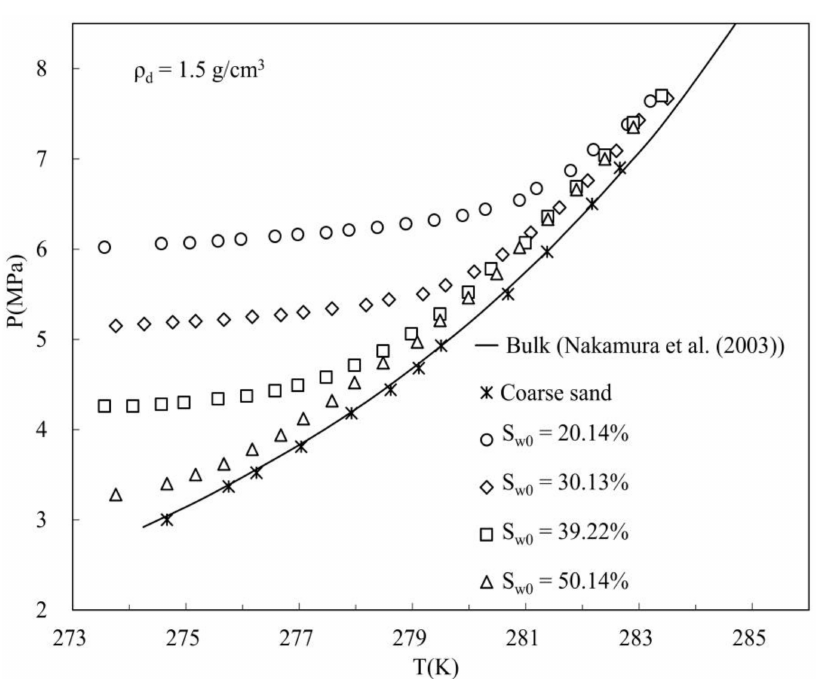
Figure 7. The stability conditions of methane hydrate in fine-grained sediment with different initial water saturation and bulk data